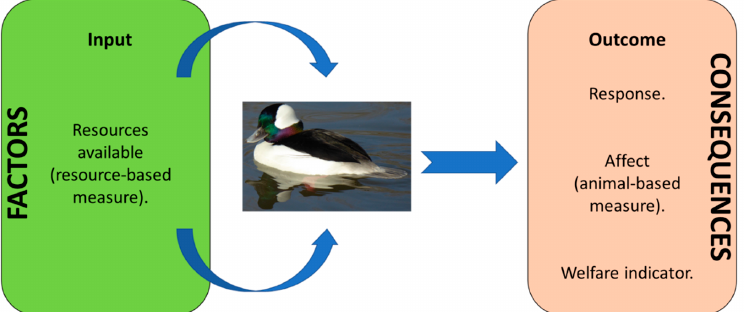
Figure 1. Integration of resource- and animal-based measures for captive waterfowl, adapted from the European Food Safety Authority (EFSA) Panel on Animal Health & Welfare [27]. Resources are those provided via management and those found within the environment.